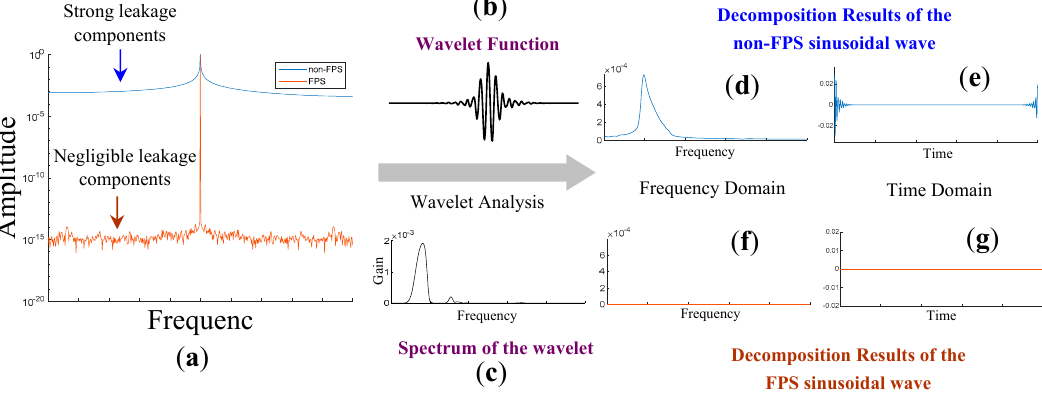
Figure 10. Mechanism of the SED effect caused by non-FPS sinusoidal waves during wavelet decomposition: ( a ) the Fourier spectrum of the two sinusoidal waves of the same amplitude; ( b ) the temporal waveform of the wavelet function; ( c ) the Fourier spectrum of the wavelet function; ( d ) the spectrum; ( e ) the temporal waveform of the sinusoidal wave not satisfying the FPS condition; ( f ) the spectrum; ( g ) the temporal waveform of the sinusoidal wave satisfying the FPS